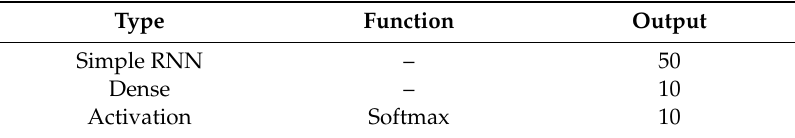
Table 4. Recurrent neural network (RNN) architecture.